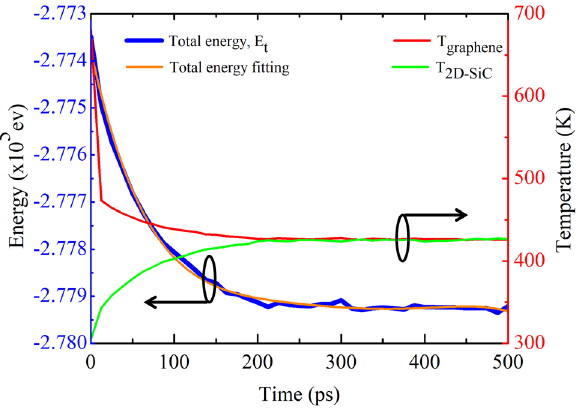
Figure 11. Temperature profiles of graphene and 2D-SiC layers as well as total energy of the graphene layer as a function of time.